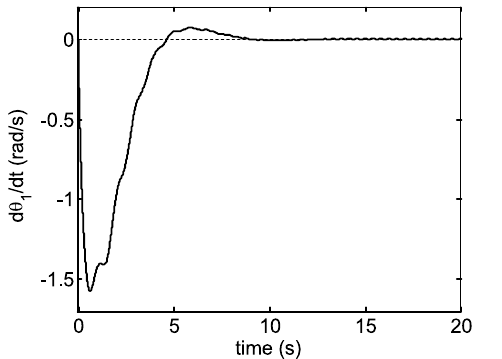
Fig. 10. Estimated behavior of variable ˙ θ 1 considering different ini- tial conditions for the angular displacements.